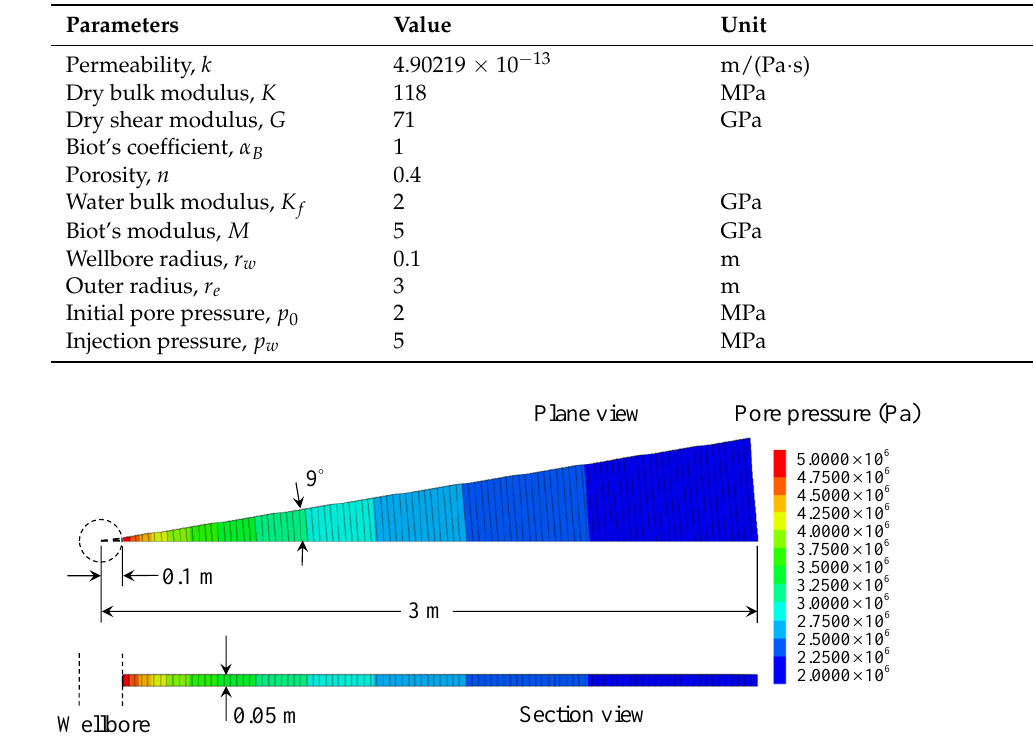
Table 2. Parameters employed in the numerical calculation (FLAC3D).